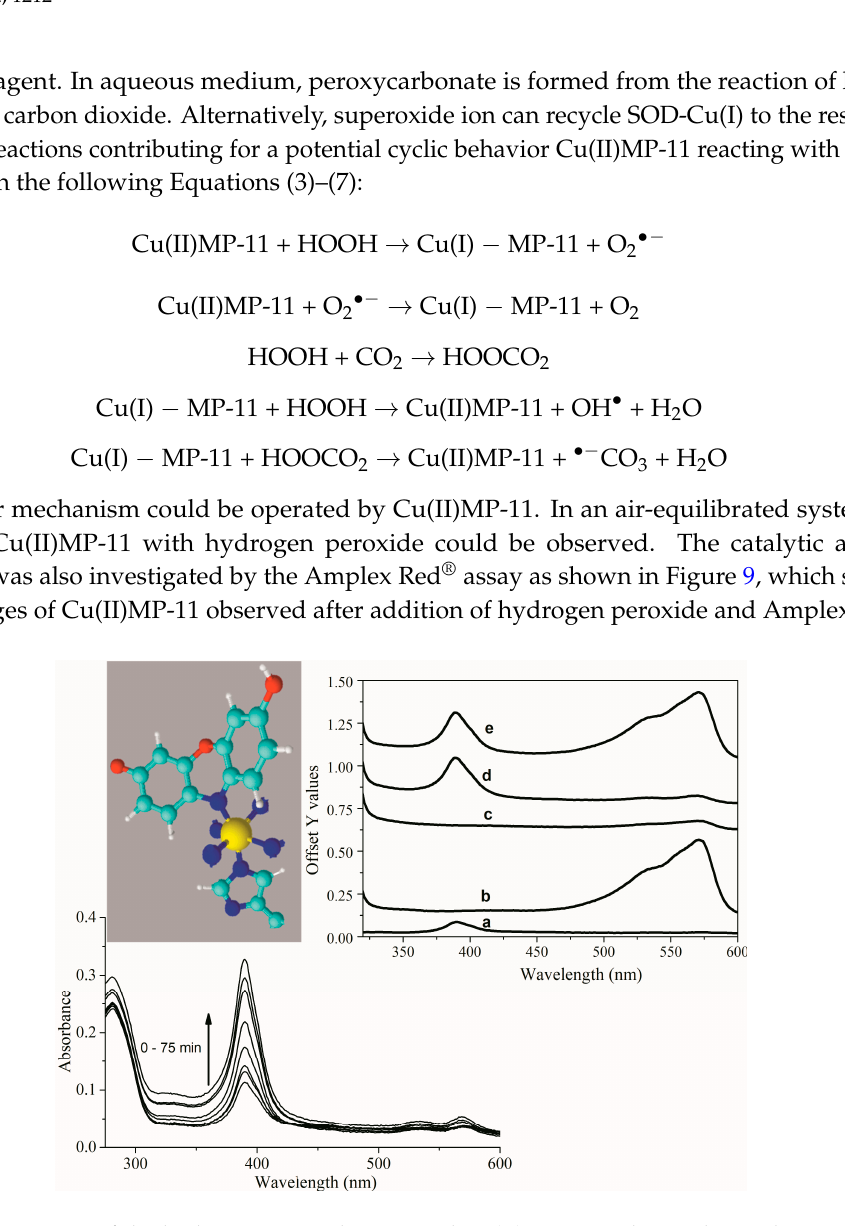
peroxide cleavage could oxidize Amplex Red to resofurin. In sequence, superoxide ion produced in